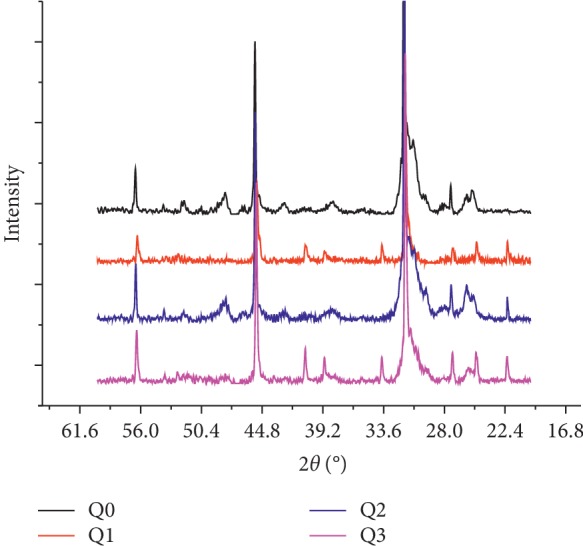
X-ray diffraction spectra.